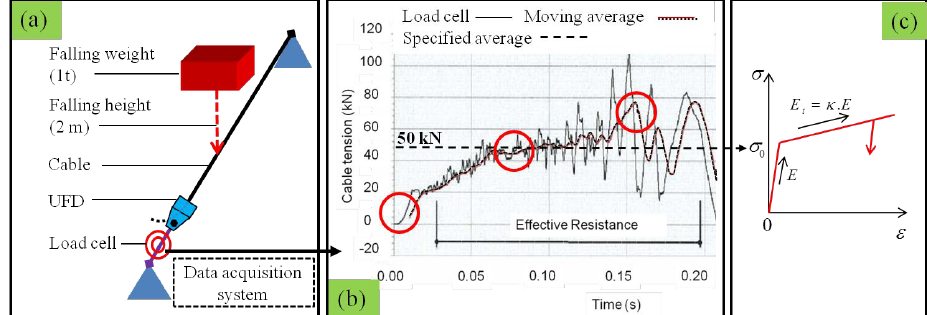
Fig. 9. Constitutive modelling of the UFDs modelled by the equivalent Truss element in the developed numerical (FE) model of the R-LPR. (a) Scheme of the falling-weight impact test (FWT) conducted by Besafe (2006). (b) A typical time history of the tension force recorded in the FWT, which very precisely recommended the average slip-tension designation of 50kN. (c) Elastic-linearly plastic/hardening constitutive model (Plastic Kinematic in LS-DYNA) considered in the FE modelling. Reproduced from Dhakal et al. (2011a).